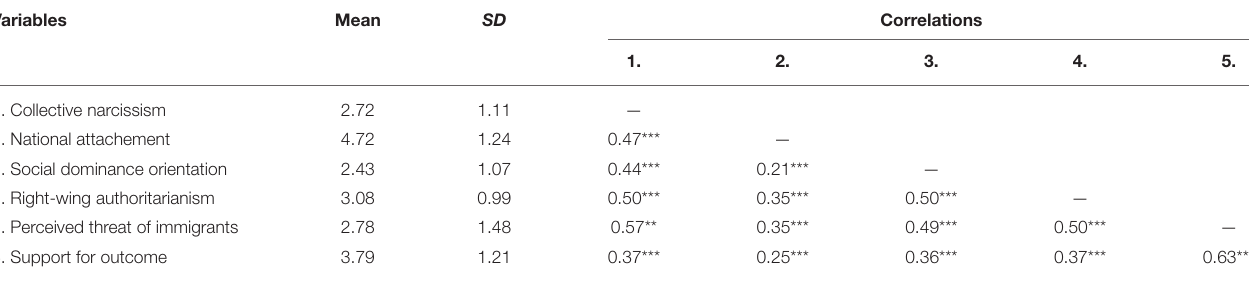
TABLE 4 | Descriptive statistics and correlations for the measurements of Study 2, N = 226.